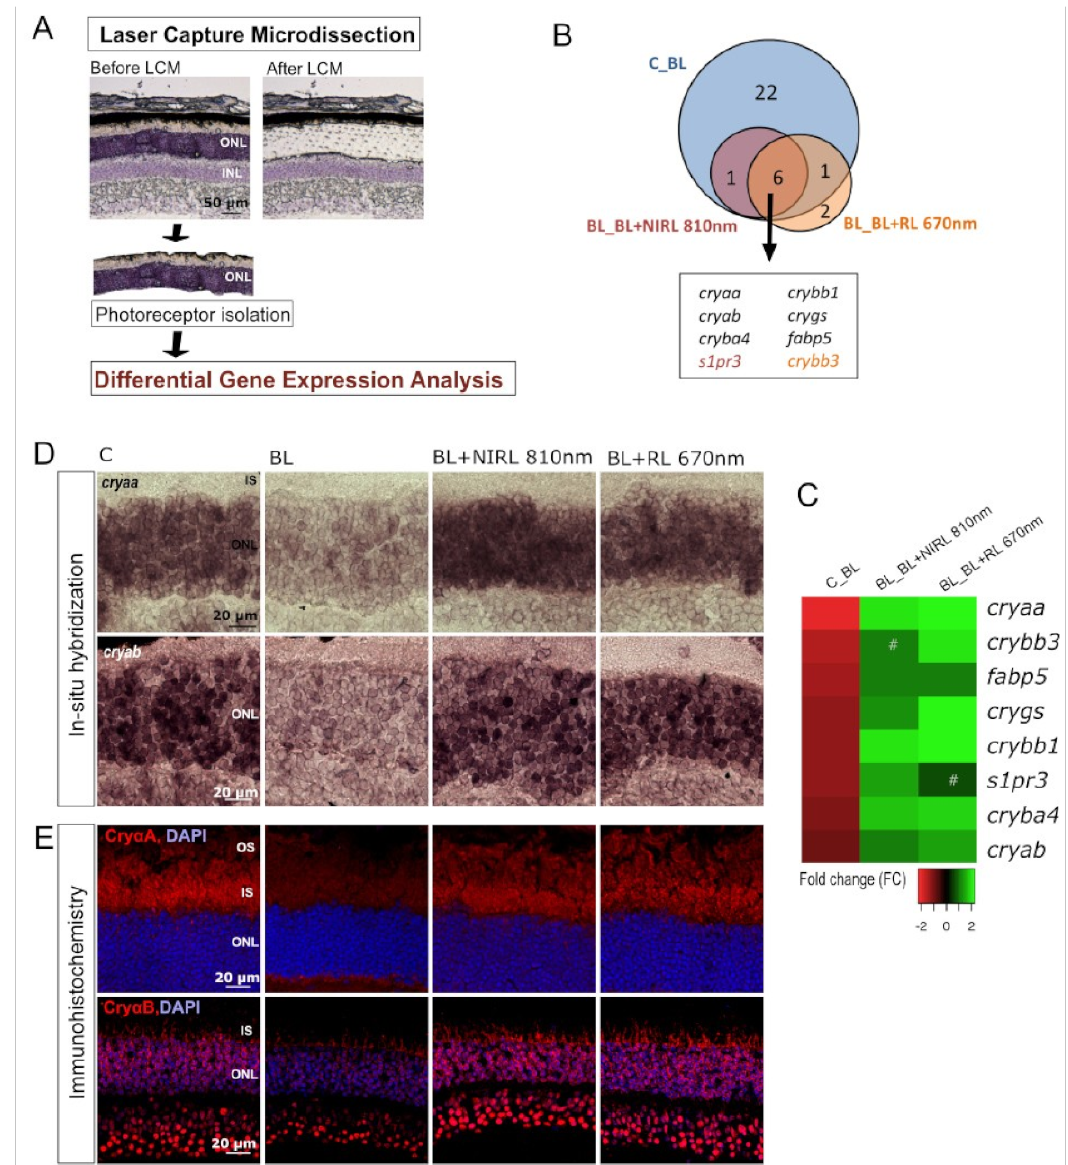
Figure 5. NIRL and RL regulated gene expression analysis of isolated photoreceptors. ( A–E ) Late event analysis after 9 h of cultivation. Eyes were treated for 6 h with BL, following 10 min NIRL or RL and post-cultivated for another 3 h. ( A ) Schematic set up of microdissected photoreceptors via Laser Capture Microdissection (LCM) for gene expression analysis. ( B ) Venn diagram illustrating overlap of significant di ff erentially expressed genes (DEGs) from C_BL, BL_BL + NIRL 810 nm and BL_BL + RL 670 nm with a cuto ff of log 2 FC > 0.5 and an adjusted p-value < 0.1 ( C ) Heatmap of overlapping up- and downregulated genes significant for C_BL and BL_BL + NIRL 810 nm or BL_BL + RL 670 nm ranked by fold change. N = 2 experiments. #—not significant. ( D ) Representative images for situ hybridization from cryaa and cryab mRNA in retinal sections. N = 3 experiments E: Representative images of Cry α A and Cry α B immunohistochemical staining in retinal sections. D, E: Retinal layers: outer segments [OS], inner segments [IS], outer nuclear layer [ONL]. N = 3